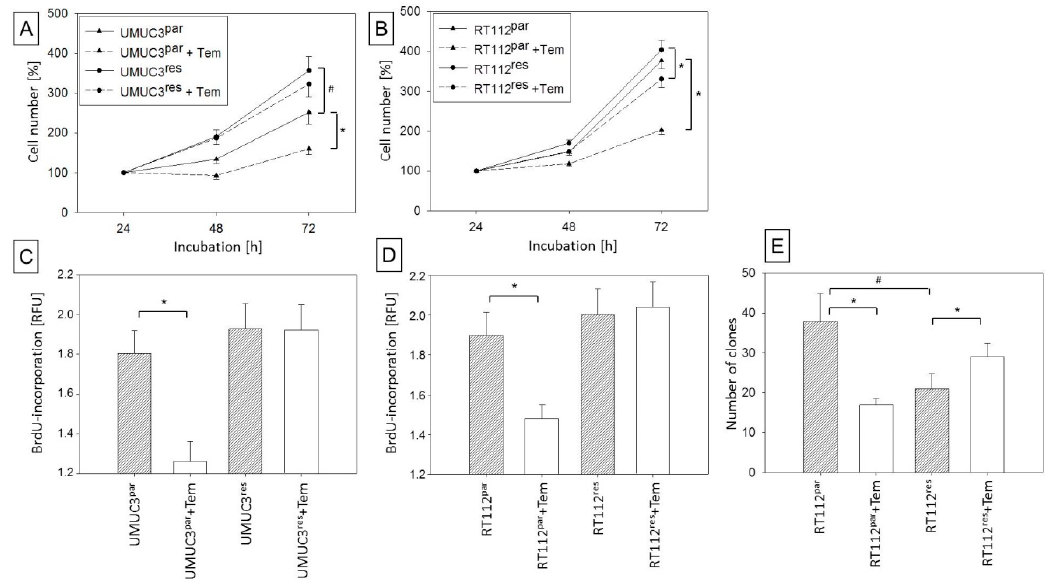
Figure 1. Growth of parental and temsirolimus-resistant bladder cancer cells. ( A ) UMUC-3 and ( B ) RT112 tumor cells exposed to 10 nmol/mL temsirolimus for 24 (100%), 48, and 72 h. Proliferation of parental and temsirolimus-resistant ( C ) UMUC3 and ( D ) RT112 exposed to temsirolimus [10 nmol/mL] during 48 h BrdU assay. ( E ) Clonal growth of RT112 par and RT112 res after 10 days incubation with temsirolimus [10 nmol/mL]. RFU = Relative Fluorescence Units. Bars indicate standard deviation (SD). * indicates significant difference to corresponding control, #indicates significant difference to parental control cells, p ≤ 0.05. n = 5.